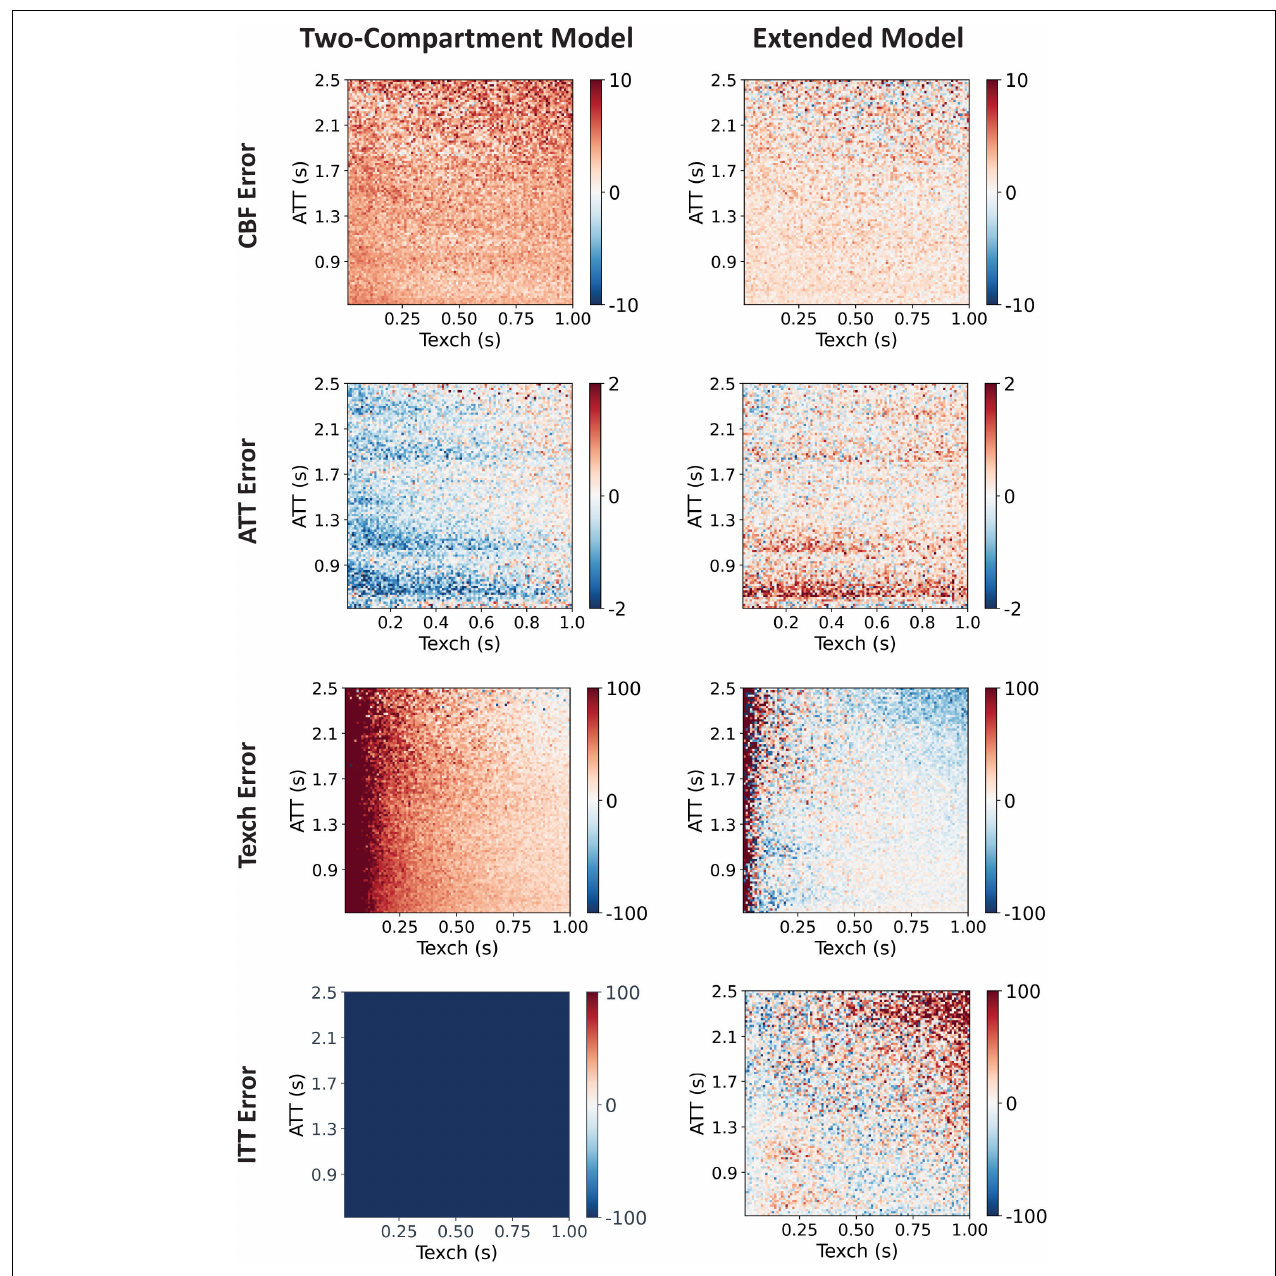
FIGURE 3 | Comparison of the two-compartment model and the extended model. The data was simulated with ITT = 200 ms and was fitted with both models, and error in terms of percentage deviations of the estimated parameters was calculated. Here, errors from all four parameters resulting from the two models are displayed. It can be observed that the two-compartment model assuming no intra-voxel transit yields more error in the estimate of all parameters. Moreover, Texch parameter is overestimated for the whole range of real Texch and even more for the lower values ( < 300 ms). In ATT error, streaks of error appear at the TI values used because there was no partial bolus delivery between the two consecutive